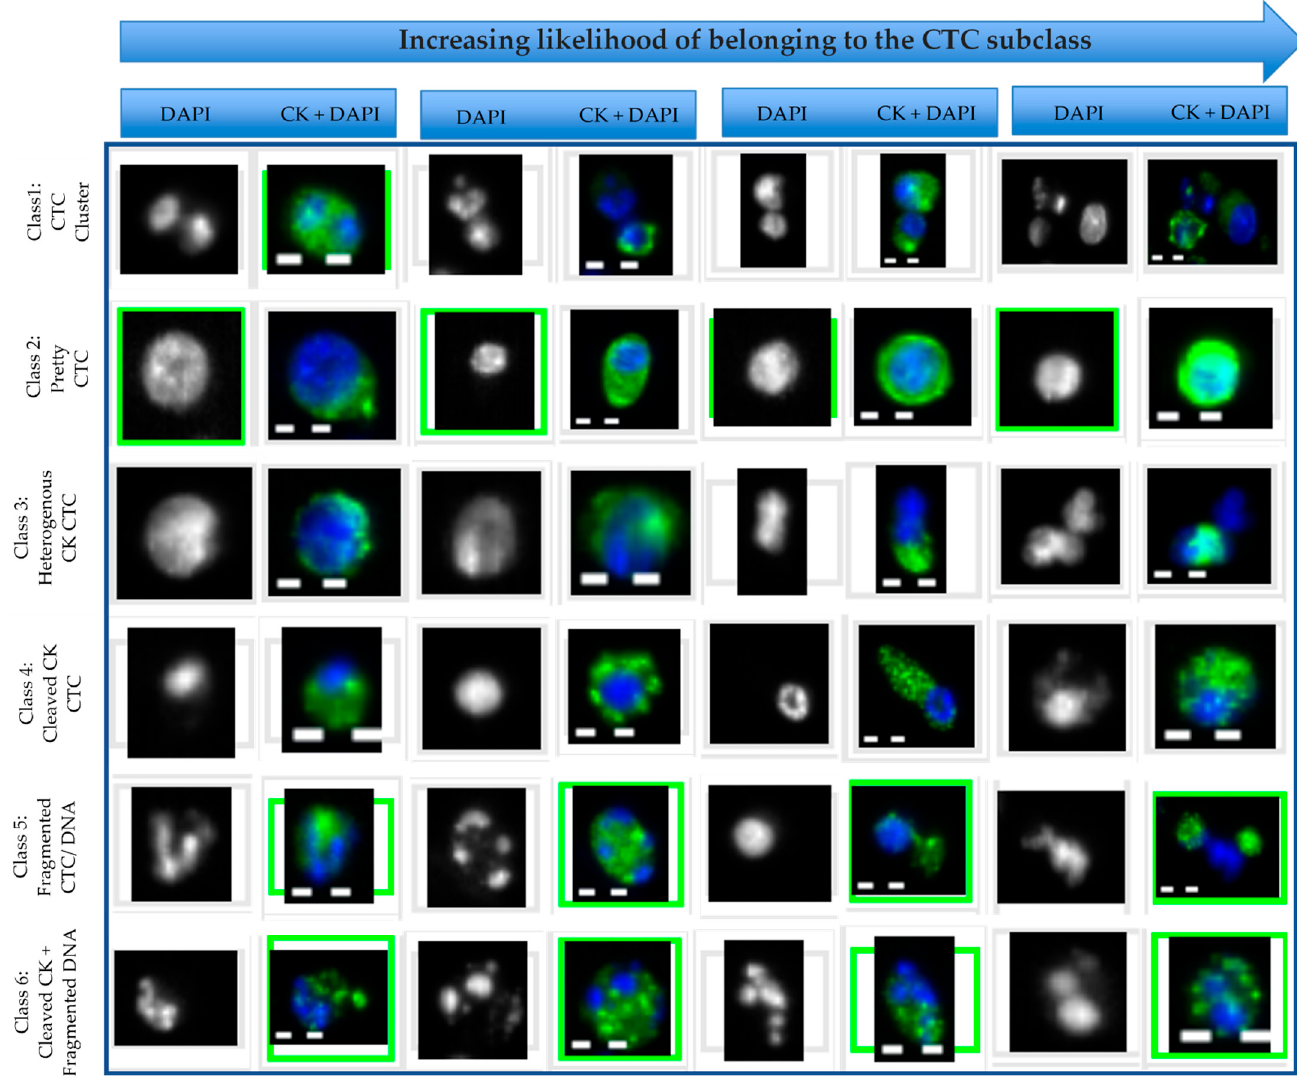
Figure 5. Examples of CTCs assigned to the different subclasses. Based on morphological appearance, six subclasses were identified: Class 1: CTC clusters; Class 2: Pretty CTC; Class 3: Heterogeneous CK CTC; Class 4: Cleaved CK CTC; Class 5: Fragmented DNA/CTC; Class 6: CTC with Cleaved CK + Fragmented DNA. For each class, the objects are shown with an increasing likelihood of belonging to the class. Composite images are shown with the nuclear stain DAPI colored blue and the cytokeratin (CK) staining colored green.